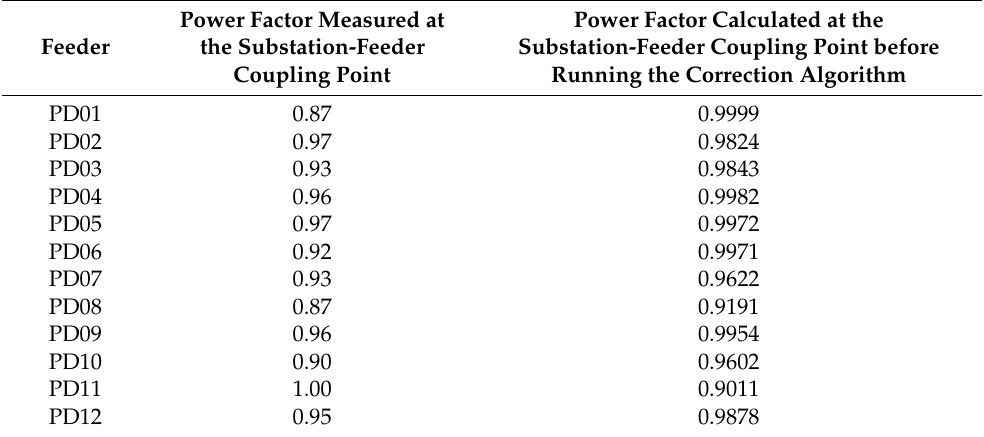
Table 4. Power factors measured in the beginning of feeders and calculated by load flow algorithm. Power Factor Measured at Feeder the Substation-Feeder Coupling Point